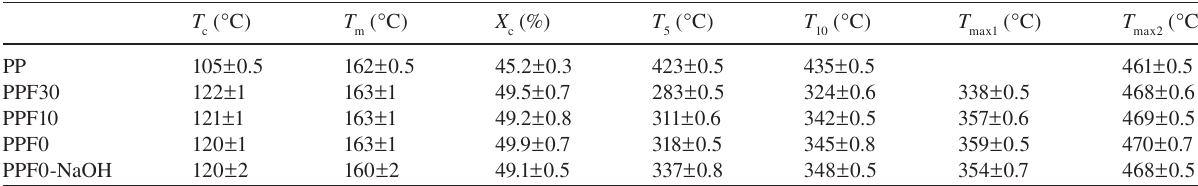
Table 4 Crystallization properties and thermal stability of PP and fl ax/PP